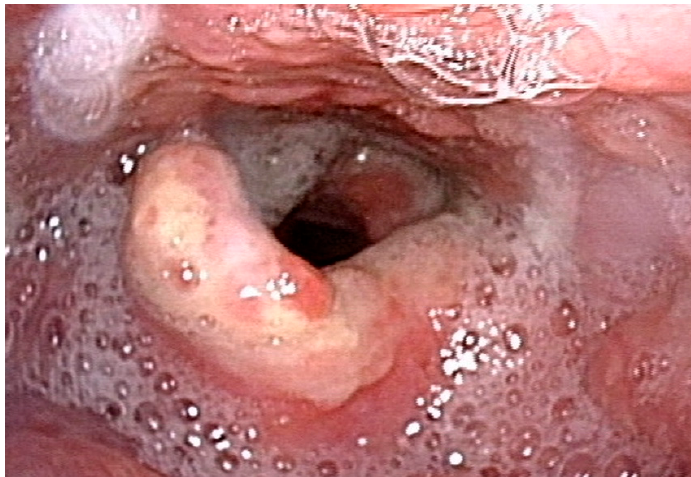
Figure 1. The 56-year-old male presented with granulation tissues over